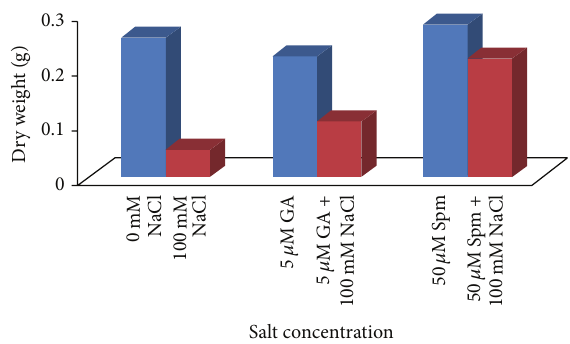
Figure 2: (a) Effect of NaCl on the root, shoot, and leaf length of 10- day-old mungbean seedling. (b) Effect of NaCl on the shoot length of 10-day-old mungbean seedling and its possible amelioration with 5 𝜇 M GA 3 and 50 𝜇 M Spm.